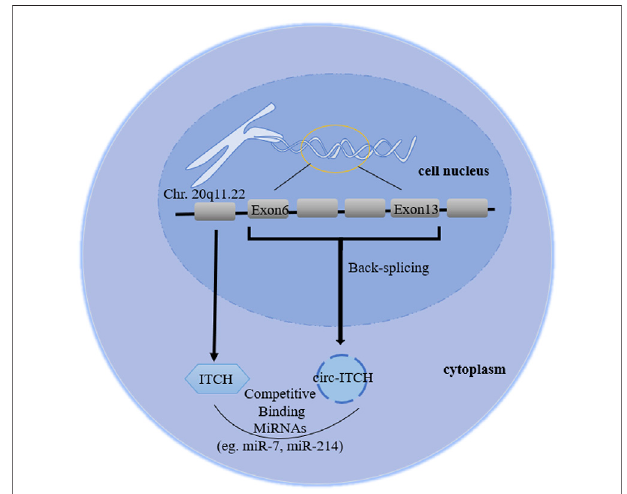
FIGURE 1 | Biogenesis diagram of circ-ITCH. The ID number of circ- ITCH is hsa_circ_0001141, whose gene is located in chr 20q11.22, derived fromexon6 – 13ofITCHcodinggene,formedbyback-splicing,anditsmature sequence is 873bp.